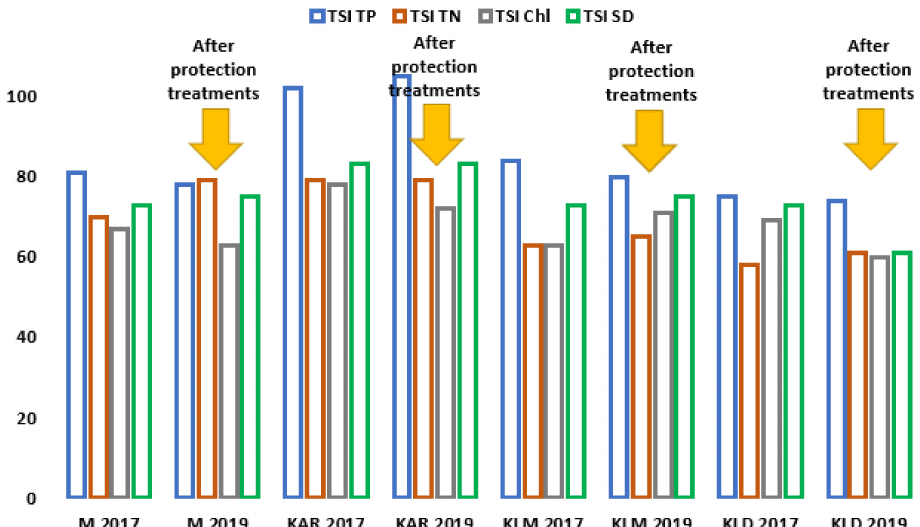
Figure 9. The Trophic Status Index (TSI) calculated on the basis of visibility (SD) chlorophyll concentrations (ChL), total phosphorus (TP) and total nitrogen